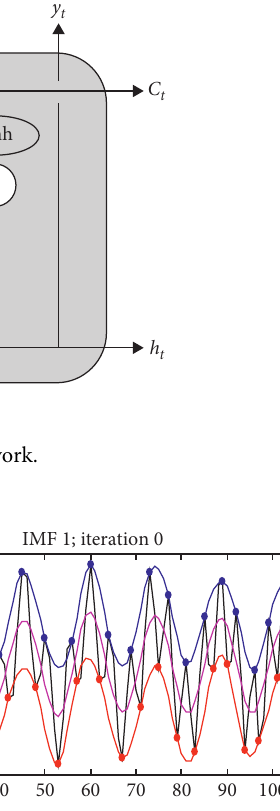
Figure 4: The decomposition process chart of